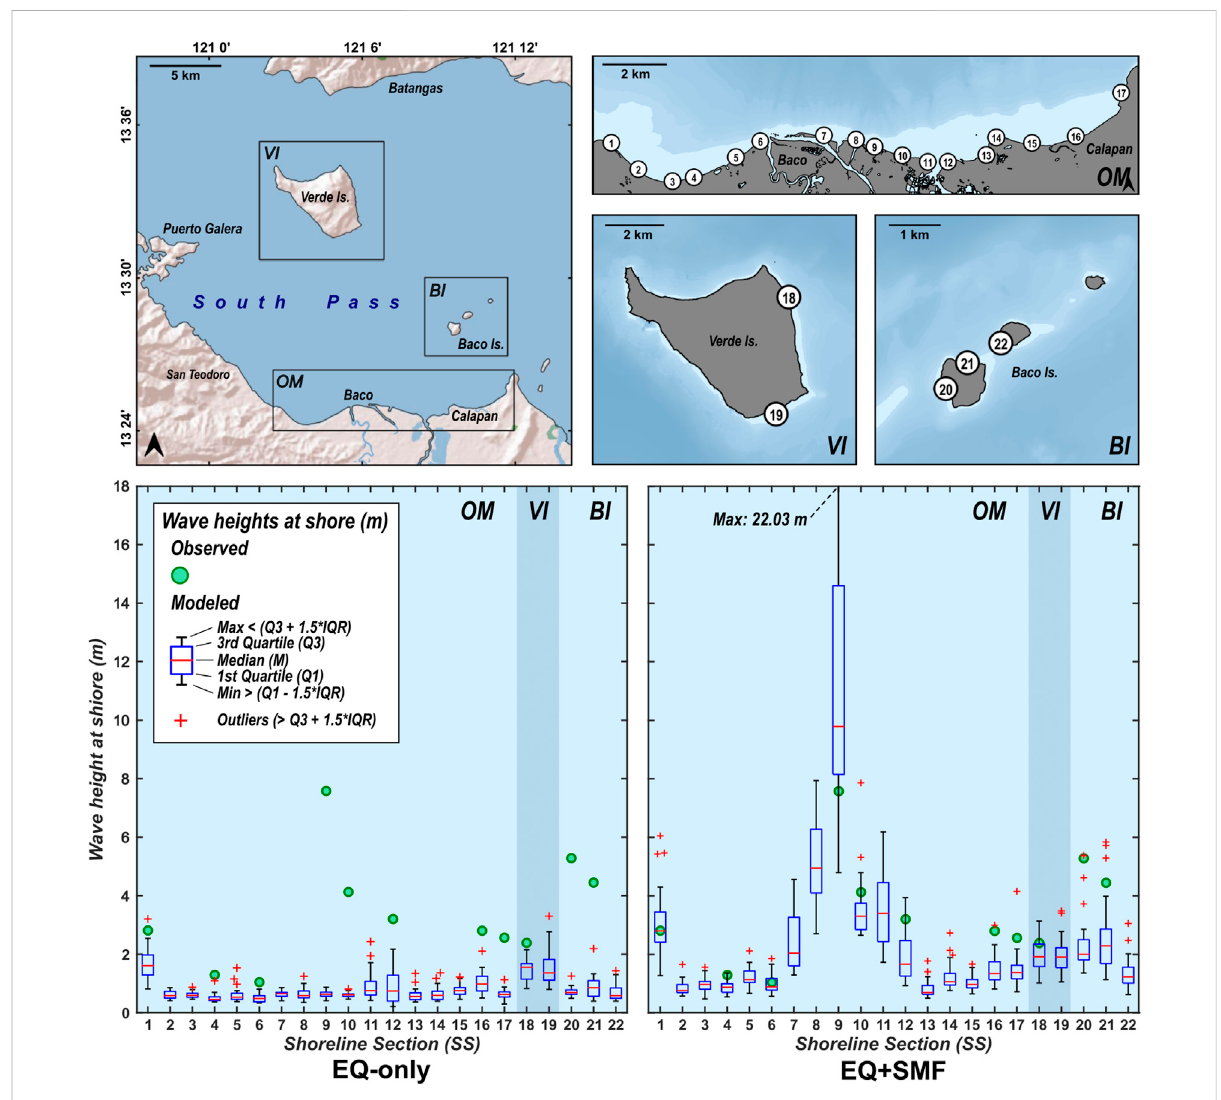
FIGURE 8 Comparison between observed and modeled (EQ-only and EQ+SMF) wave heights. The upper panels show the locations of the shoreline sections,while thelowerpanels showtheboxplots ofmodeledwaveheightsfor theEQ-onlyand EQ+SMFtsunami models. Observedwaveheights are derived from run-up measurements by Imamura and others (1995), based on the wave-height-at-shore and run-up empirical relationship equation by Smart and others